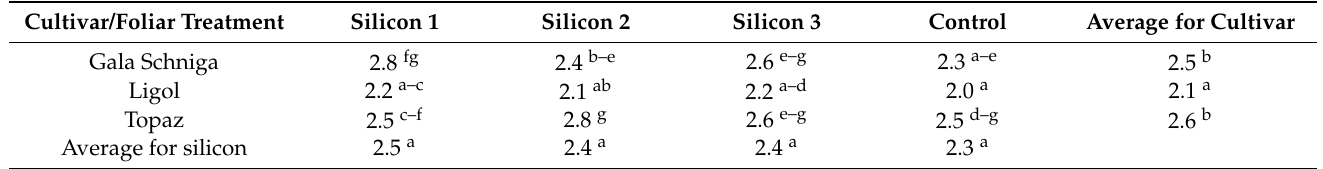
Table 1. The crown volume of apple trees depends on cultivar and foliar silicon treatment (m 3 ).